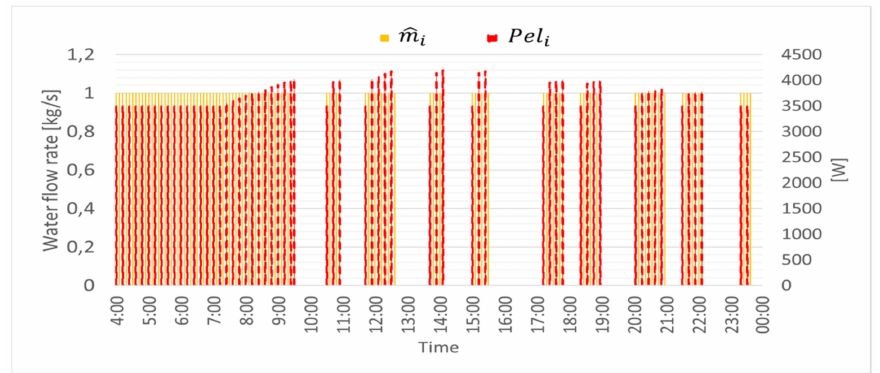
Figure 9. Pel i and ˆ m i values in the reactive approach.